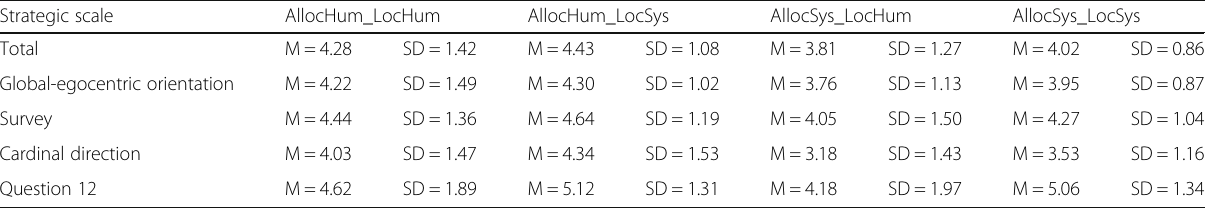
Table 2 No difference in participants ’ self-assessed spatial strategies scores across groups (means and standard deviations) Strategic scale AllocHum_LocHum AllocHum_LocSys AllocSys_LocHum AllocSys_LocSys Global-egocentric orientation